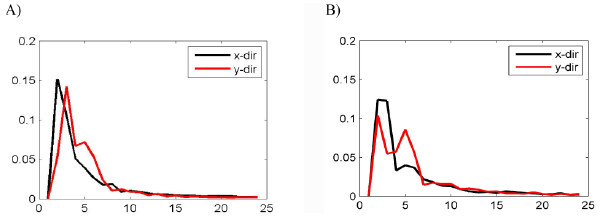
Fig. 8. (A) Aerial photograph of a natural vegetation pattern in So- malia (7 ◦ 43 0 N, 48 ◦ 02 0 E); (B) Digitized representation of the veg- etation cover of the natural pattern in (A) . (C) Sample simulated